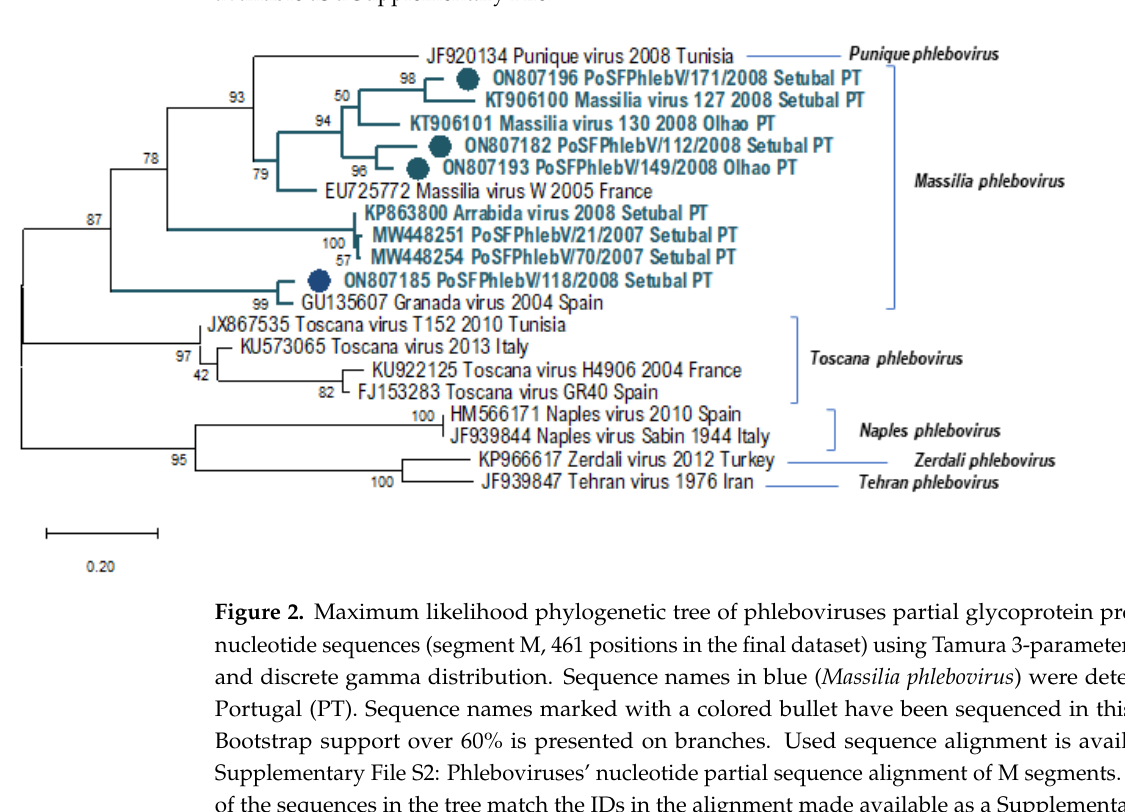
Figure 1. Maximum likelihood phylogenetic tree of phleboviruses’ partial nucleocapsid nucleotide sequences (segment S, 674 positions in the final dataset) using Kimura 2-parameter model and discrete gamma distribution. Sequence names in blue ( Massilia phlebovirus ), in red ( Alcube phlebovirus ), and yellow (New phlebovirus?) were detected in Portugal (PT). Sequence names marked with a colored bullet have been sequenced in this study. Bootstrap support over 60% is presented on branches. Used sequence alignment is available in Supplementary File S1: Phleboviruses’ nucleotide partial sequence alignment of S segments. Names of the sequences in the tree match the IDs in the alignment made available as a Supplementary File.